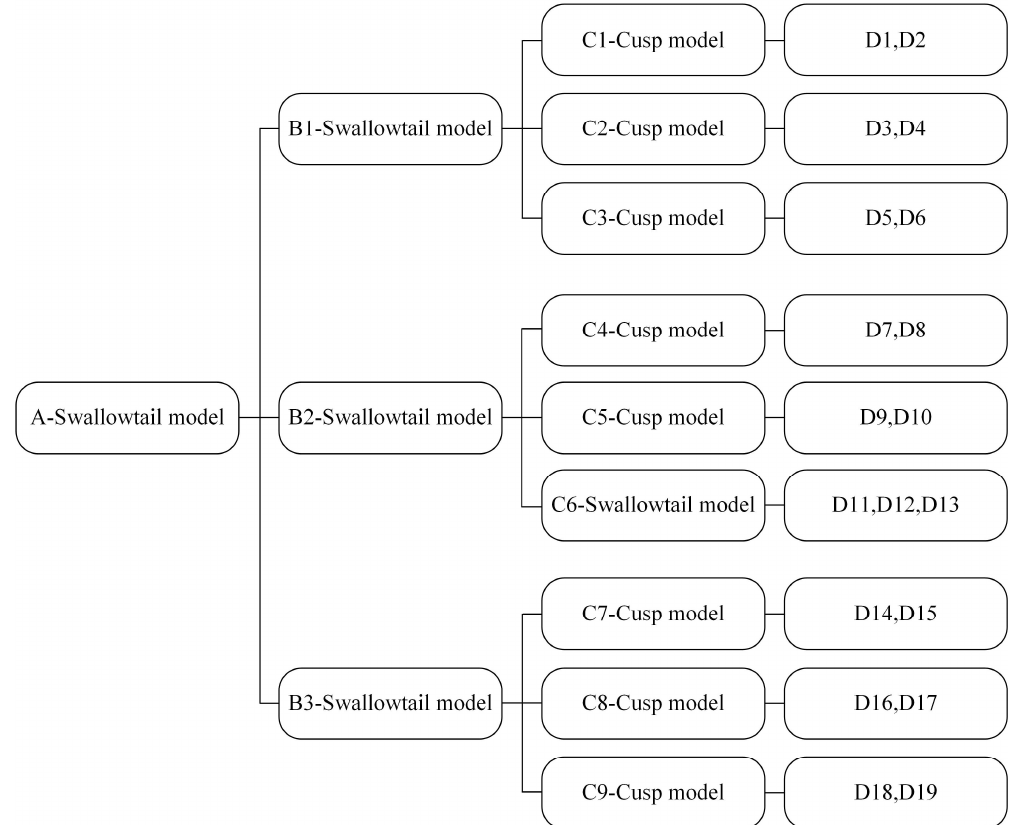
Figure 3. Catastrophe progress model integrating with